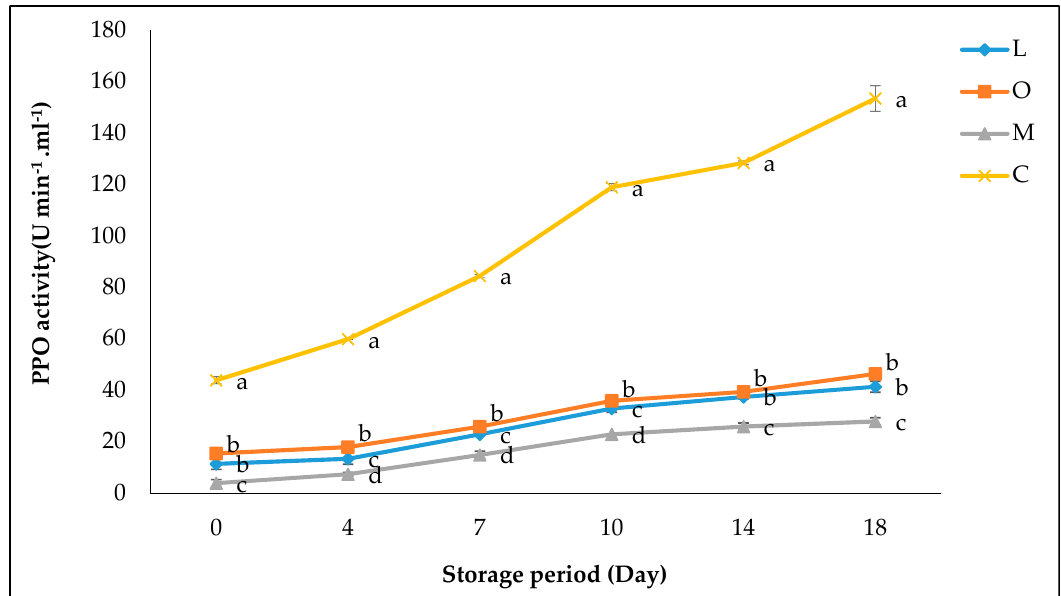
Figure 14. Effect of different essential oil emulsions (L = lemon, O = orange, and M = mandarin essential oil) on polyphenol oxidase activity (PPO) of strawberry fruits stored at 2 °C for 18 days. Vertical bars indicate the standard deviation (n = 6). Means and different letters indicates significant difference between treated and control fruits at each storage period (Duncan’s of 95%). Table 3. E ff ect of di ff erent essential oil emulsions (L = lemon, O = orange, and M = mandarin essential oil) on color, texture, appearance of strawberry fruits stored at 2 ◦ C for 18 days. Di ff erent letters indicates significant di ff erence between treated and control fruits at each storage period (Duncan’s of